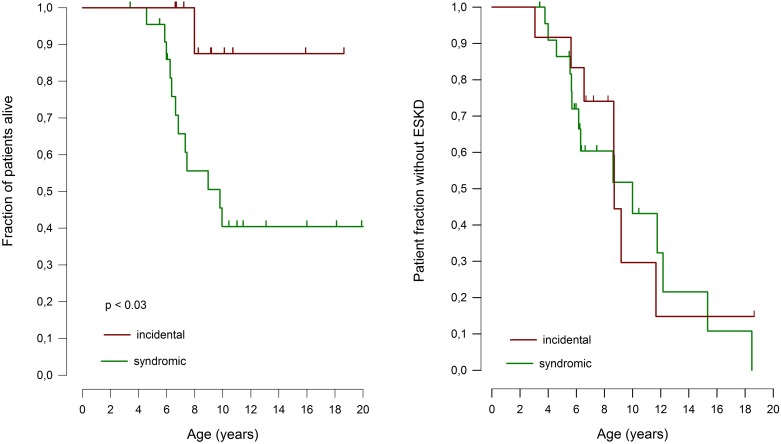
Patient survival (left) and ESKD-free survival rate (right) of patients with Schimke immunoosseous dysplasia diagnosed based on phenotype vs. patients diagnosed incidentally through SRNS-panel gene testing.Patients who deceased before reaching ESKD were censored in the renal survival analysis.